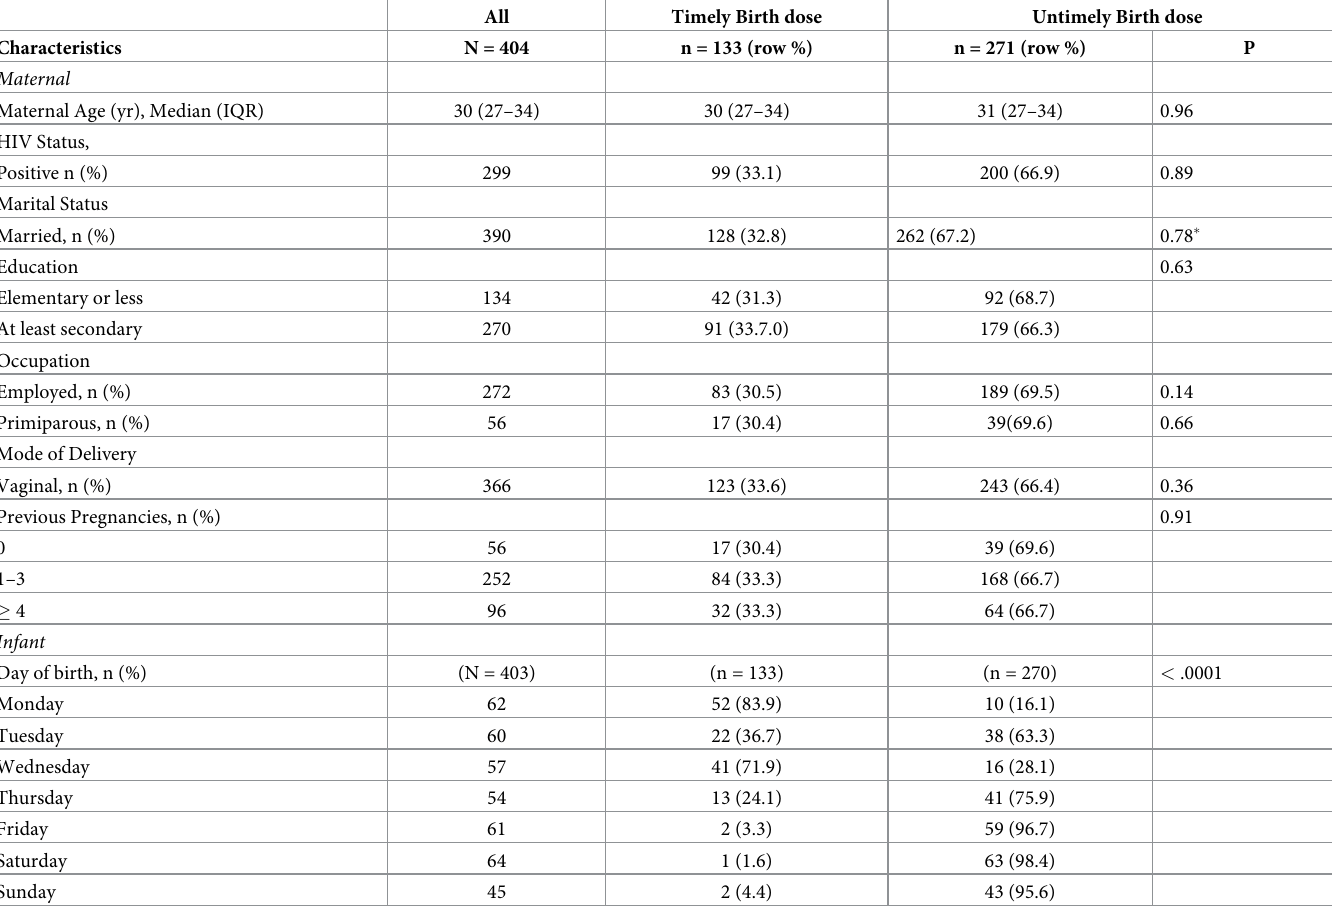
Table 1. Comparison of maternal and infant characteristics of infants who received a timely birth dose of HBV vaccine with those that did not.